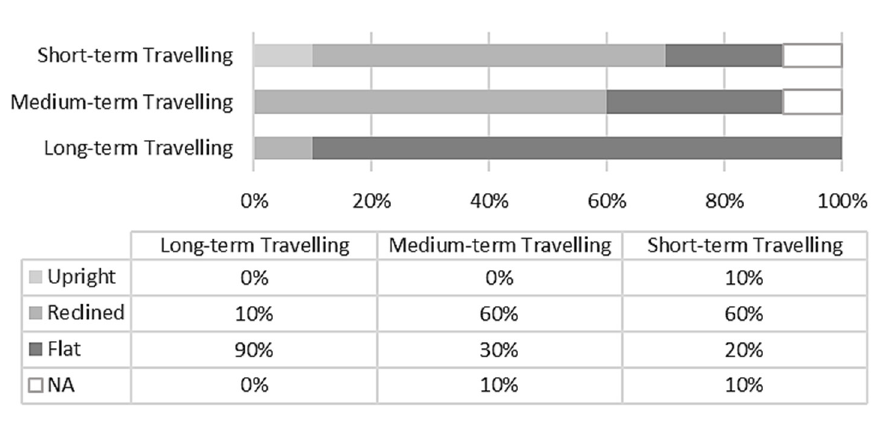
Figure 9. Preference of seat configuration for sleeping during long-, medium- and short-term travel.